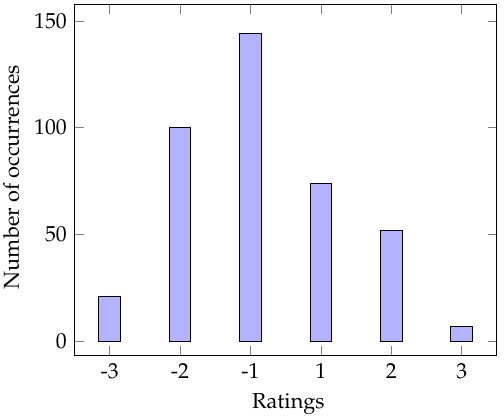
Figure 2. Distribution of ratings for the data